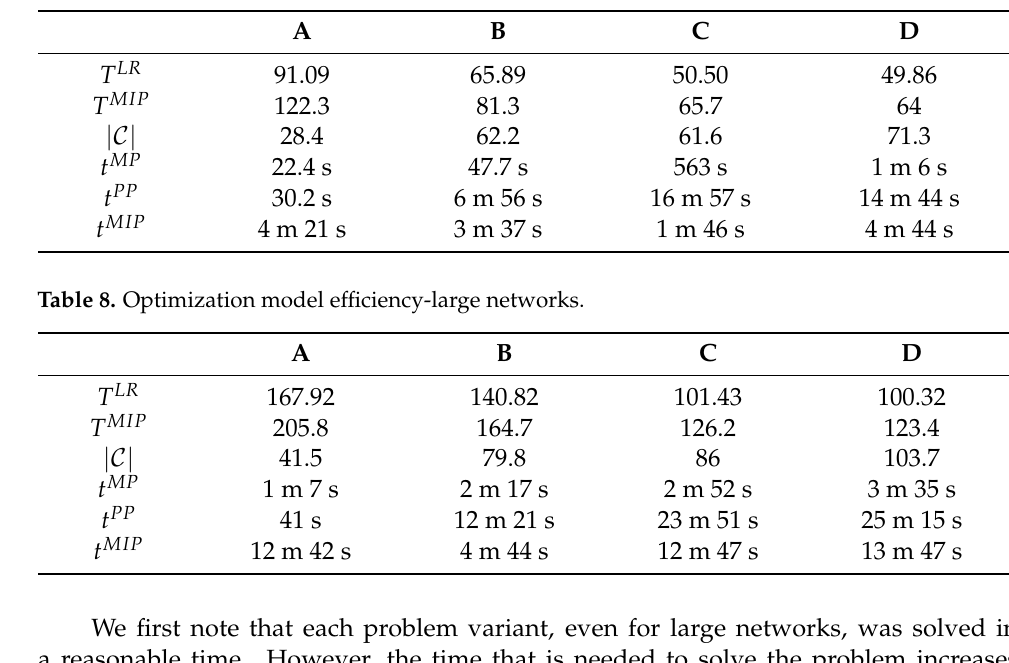
Table 7. Optimization model efficiency-medium networks.